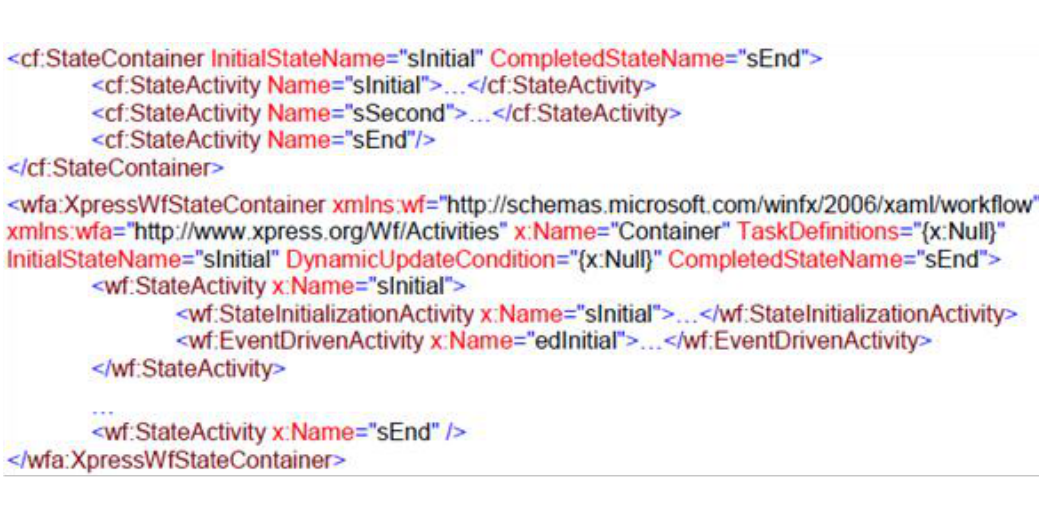
Figure 10. Template definition for State